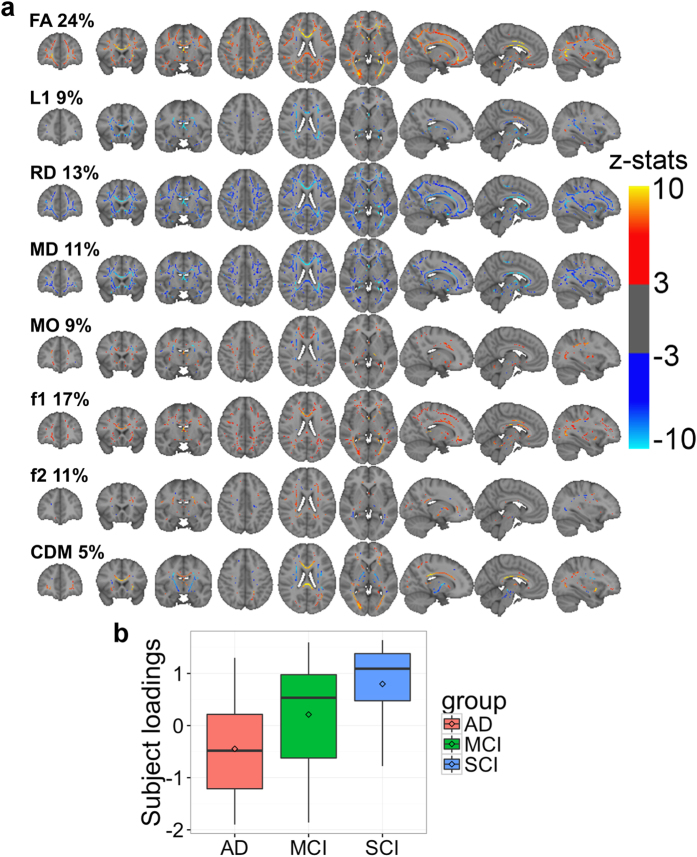
Spatial maps (a) and subject loadings distribution (b) of IC0. The spatial maps represent the thresholded z-scores (3 < |z| < 10). In the spatial maps, the weights (in percentage) indicate the relative contribution of each measure to the component at the group level. In the subject loading plot, the box represents the 25% and 75% quantiles, the horizontal bar in the box representing the median, and the diamond the mean. The plot shows a graded pattern of AD < MCI < SCI.